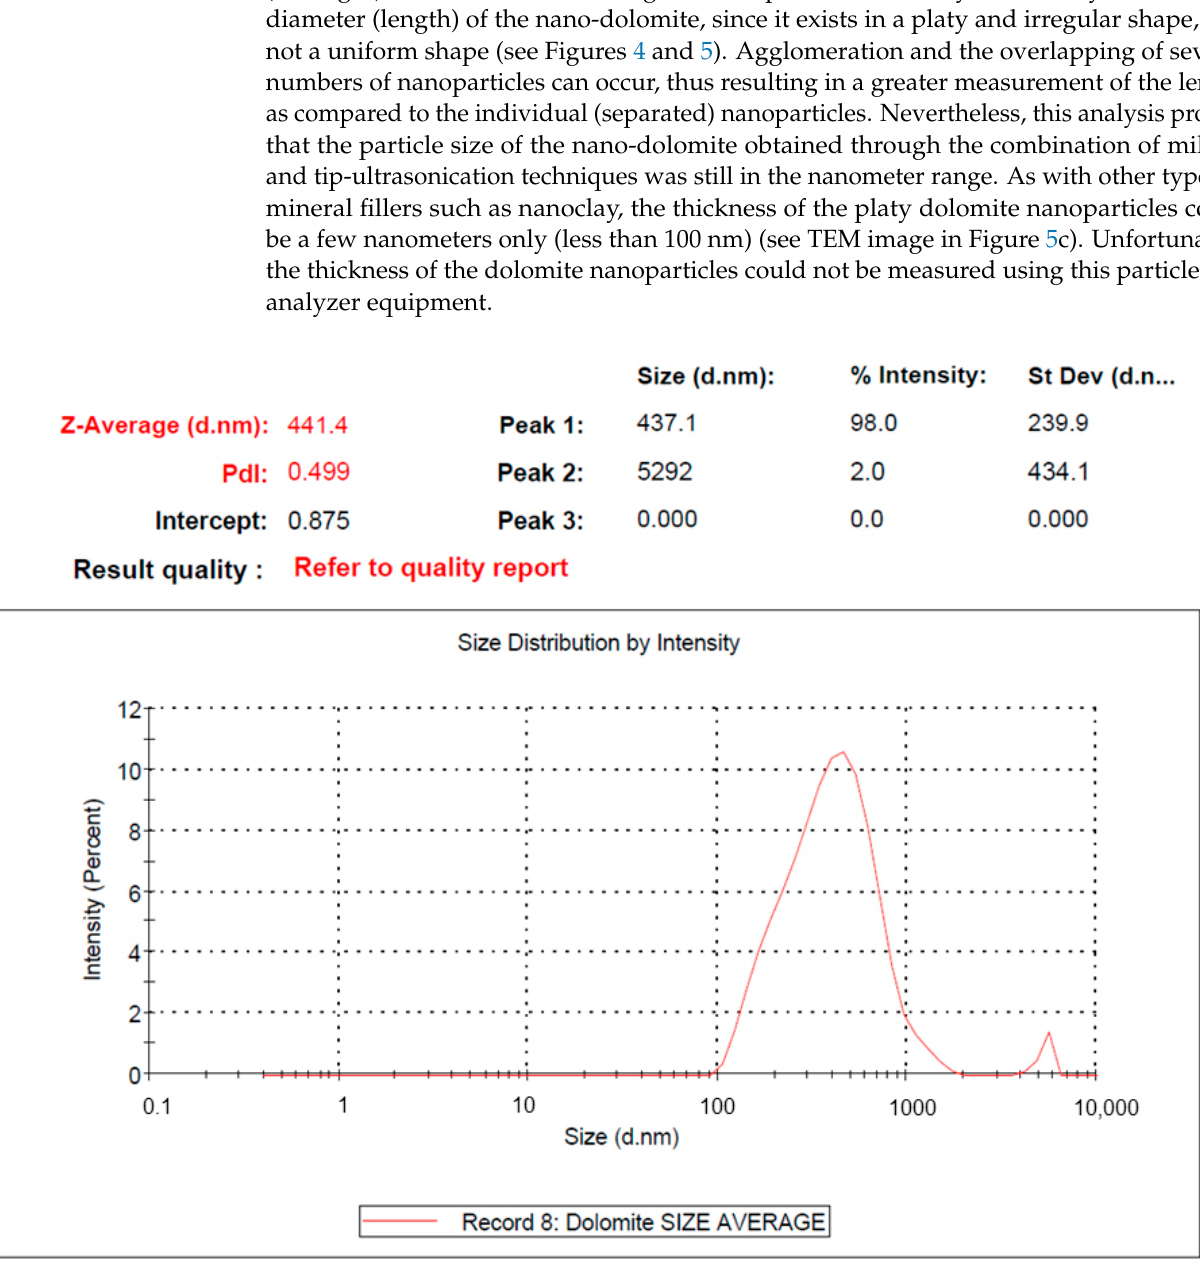
Figure 6. Particle size analysis of the dolomite nanoparticles (DNPs) obtained through milling and tip-sonication processes.